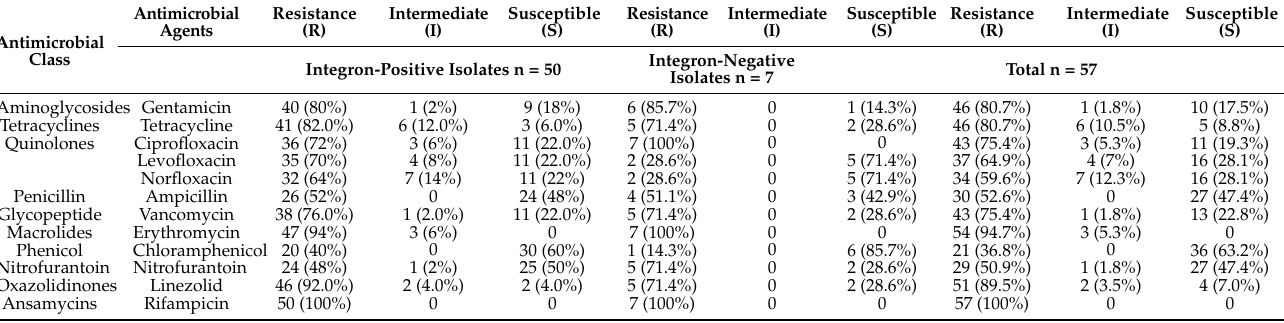
Table 1. A link between the antibiotic profiling and class 1 integrons in Enterococcus